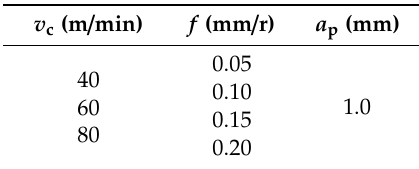
Table 2. Cutting